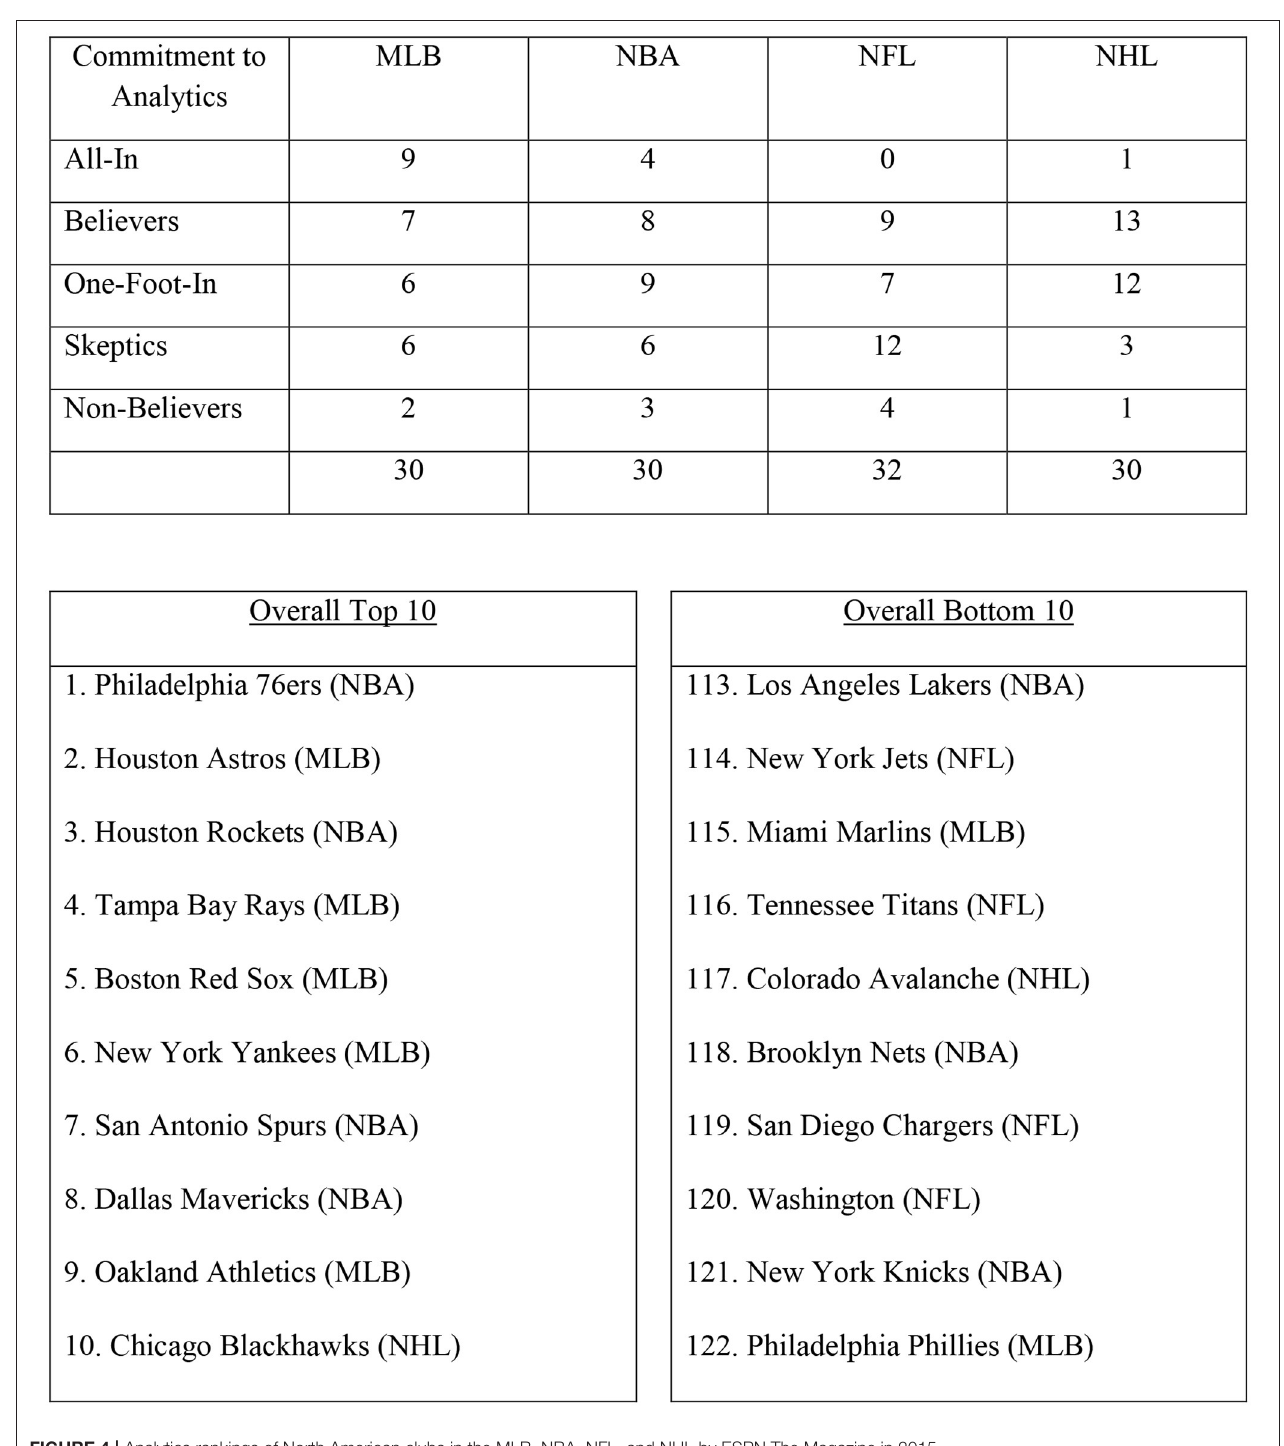
training session or competition. Prior to the development and consistent use of such wearables by all players, the available date on player training was less structured, covered fewer variables, and was less reliable (in part due to inter-observer